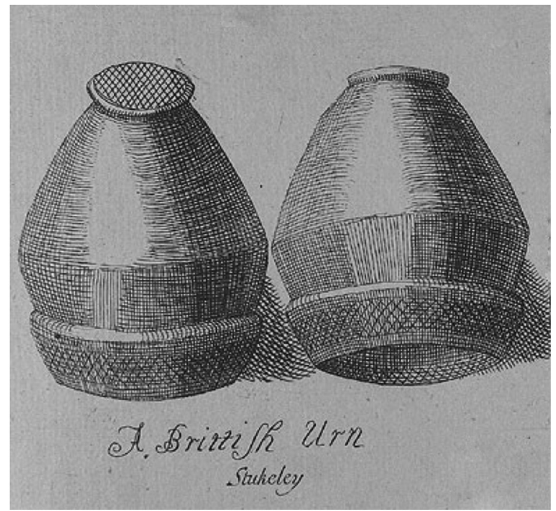
Figure 4: Engraving of “ a British Urn, ” by William Stukeley, 1717. It is depicted from two sides to provide information about the rim and base. Reproduced with the kind permission of the Society of Antiquaries of